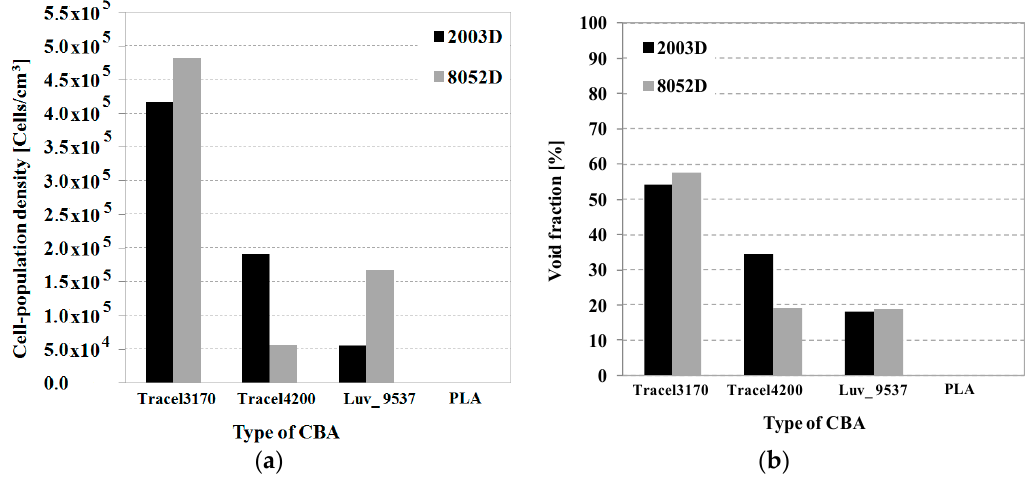
Figure 9. Foamed sample ( a ) expansion values ( b ) density values (manufacturing temperature 190 ◦ C).